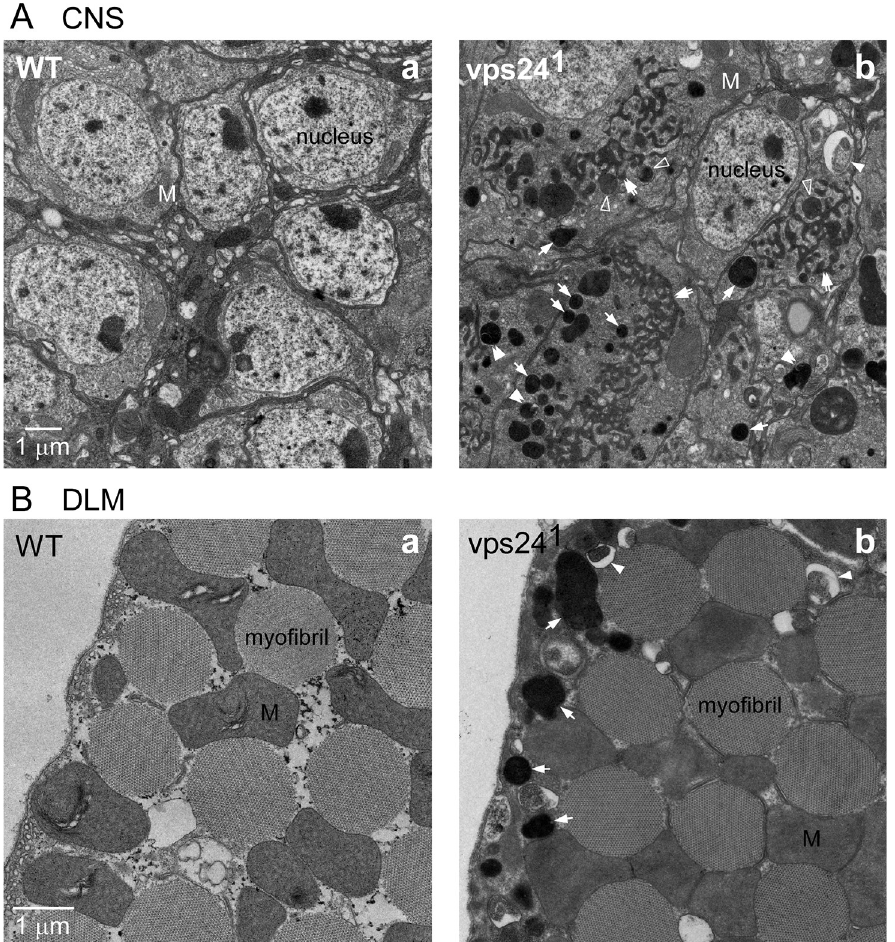
Fig 10. Ultrastructural analysis of the vps24 mutant. Transmission electron microscopy images of CNS neurons (A) and DLM (B) from WT (a) or the vps24 mutant (b) . The vps24 mutant exhibited accumulation of autolysosomes (arrows) and tubular membrane compartments (double arrows) as well as autophagosome structures (filled arrowheads), whereas these were absent in WT. The electron dense tubular membrane compartment appeared to be continuous with some electron dense spherical autolysosomes (open arrowheads). In mutant muscle, mitochondria appear to be swollen. Double arrowheads, autophagic intermediates closely associated with spherical autolysosome structures (see S10 Fig); M,